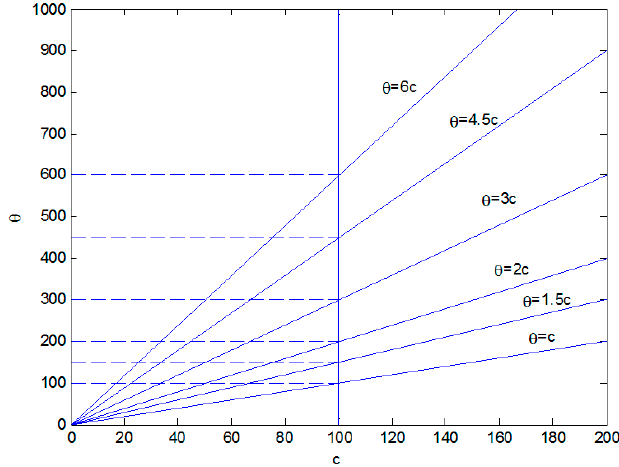
Figure 2. The function of θ on c ( n = 4).